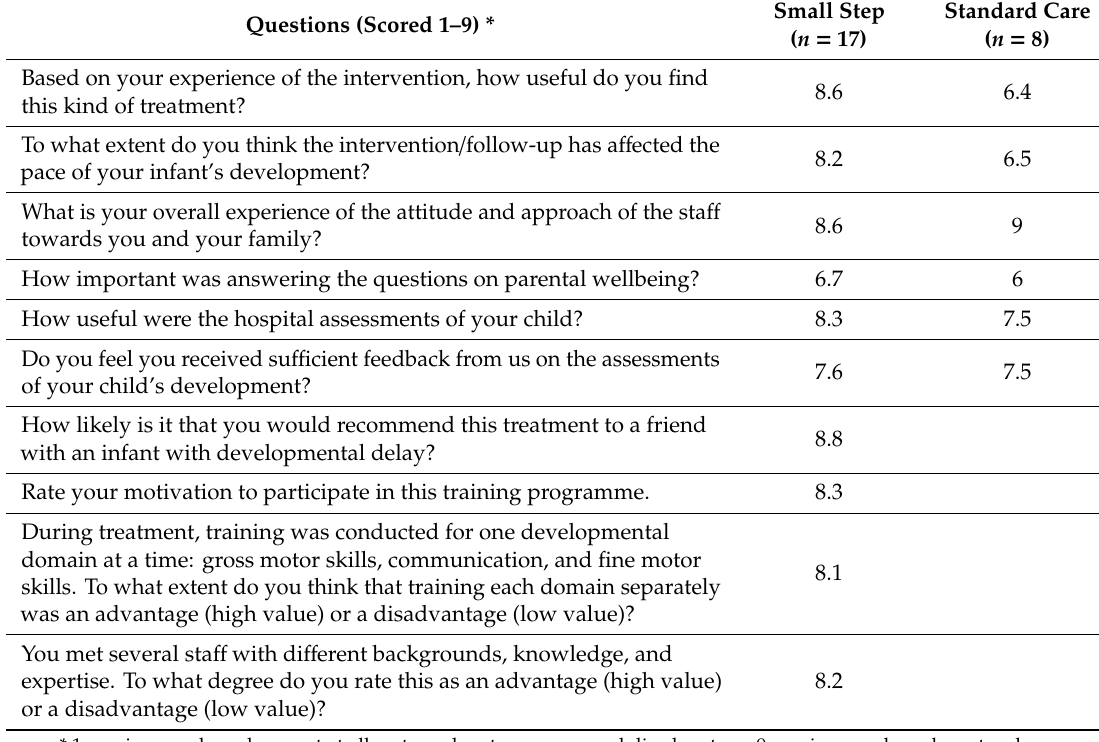
Table 5. The following questions were included in the parental questionnaire concerning the feasibility and acceptability of the